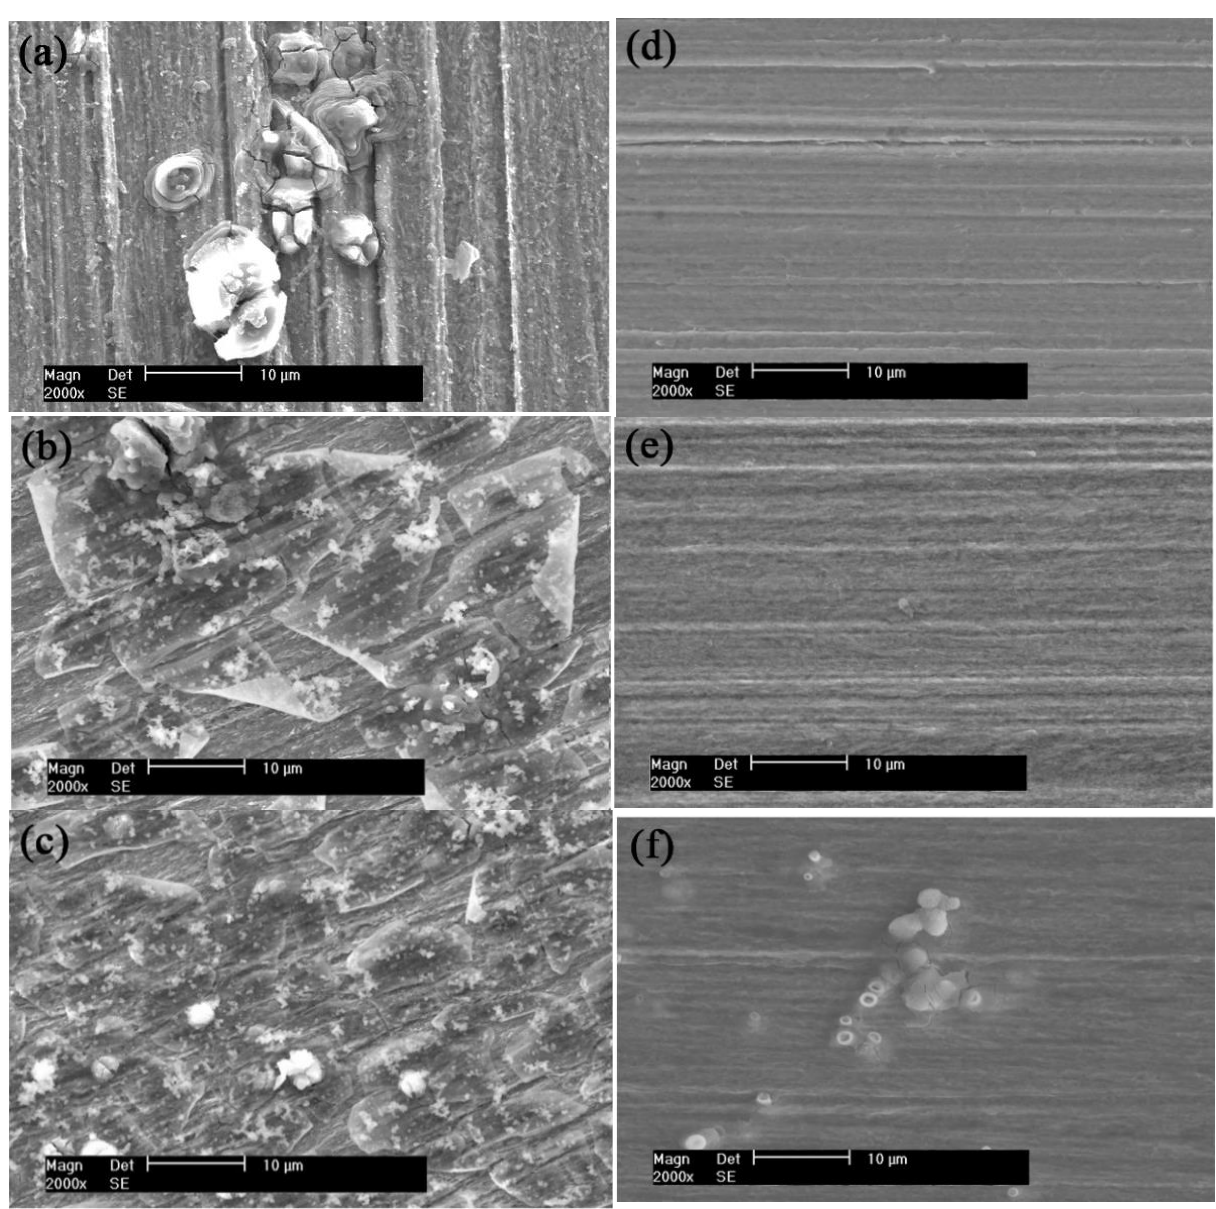
Figure 1. The morphology of corrosion products on the surface of samples under the aerobic conditions with 0 ppm ( a ), 50 ppm ( b ), 100 ppm ( c ) and anaerobic conditions with 0 ppm ( d ), 50 ppm ( e ), 100 ppm ( f ).